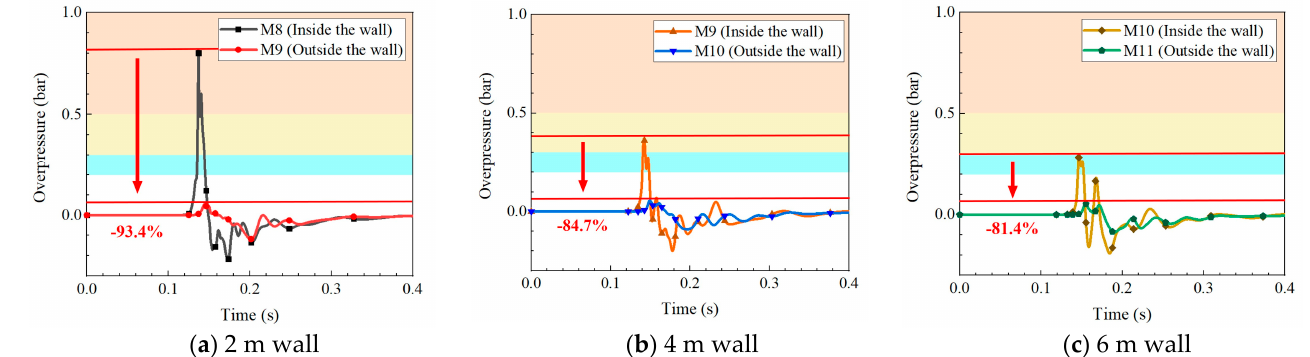
Figure 10. Evolution of the hydrogen overpressures in front of the SHRS for various protective wall distances.